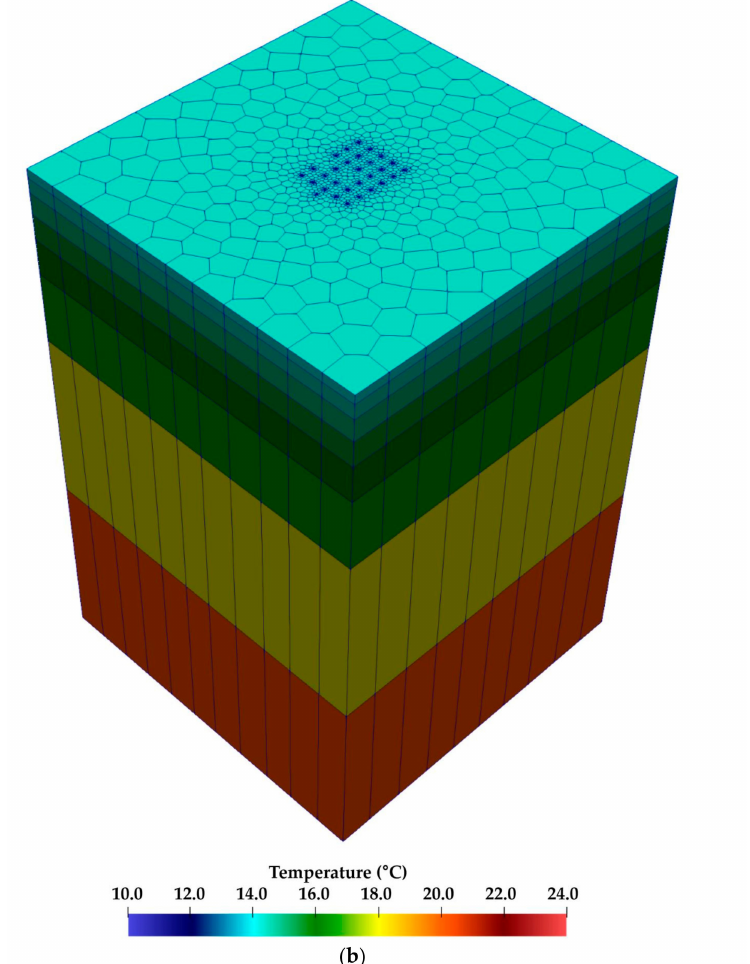
Figure 9. Boundary conditions of the simulations for future changes in ground temperature: ( a ) the annual mean GSTs of Daejeon used as the time-dependent upper boundary condition of the simulations for future changes in ground temperature. Possible SATs obtained from each RCP scenario were converted to GSTs. ( b ) the initial temperature distribution for lower and sides boundary conditions.